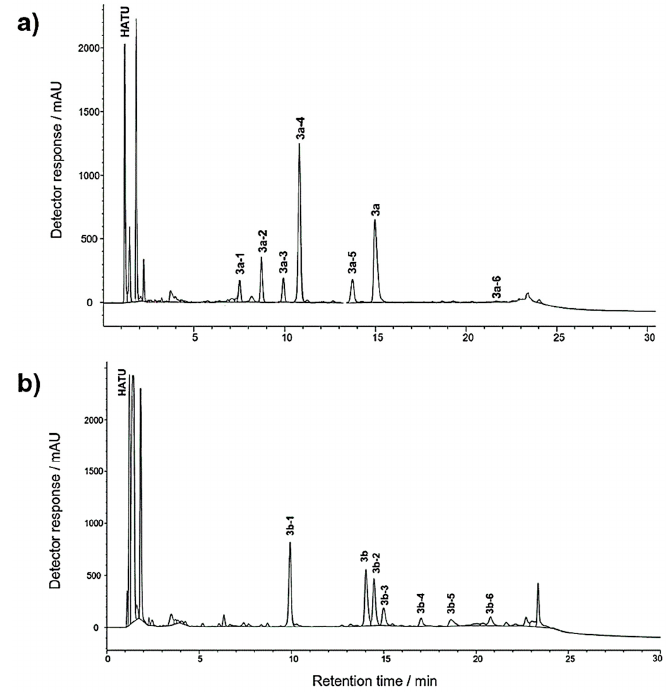
Figure 2. LC chromatogram of reaction mixture components of ( a ) 3a -macrozone and ( b ) 3b -macro- zone.